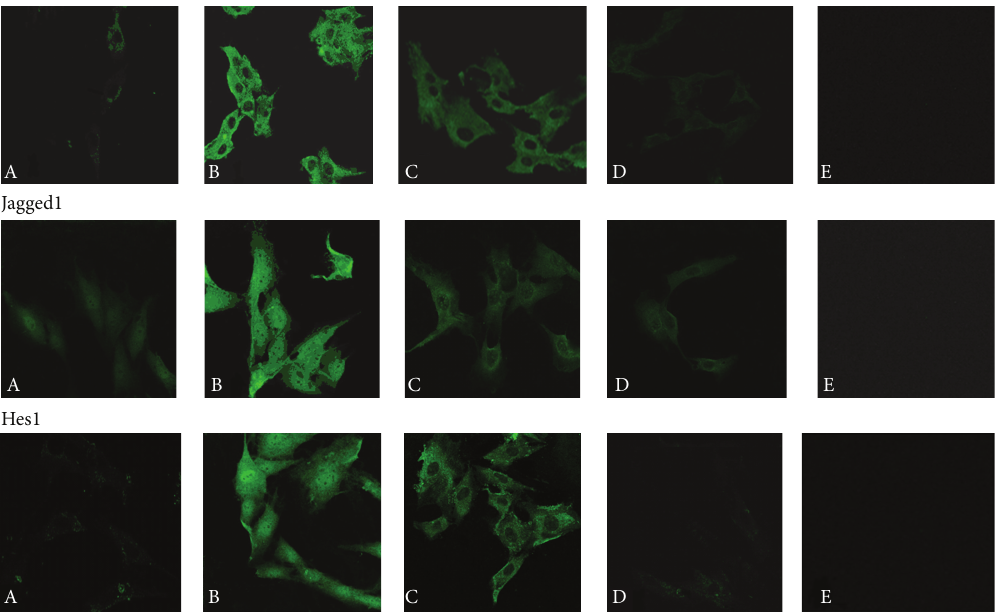
Figure 7: The expression of Notch pathway components in GMCs by immunofluorescent staining and laser scanning confocal microscopy applications. A, NC group; B, HG2 group; C, HD group; D, OP group; E, Negative control. Notch pathway component proteins were detected in the cell as green fluorescence. The Notch pathway components protein was little detected in the NC group, but it was prominent in the HG2 group, which did not significantly change as the result of high osmotic pressure. The protein was less detected in the DAPT intervention group. Original magnification ×630 .